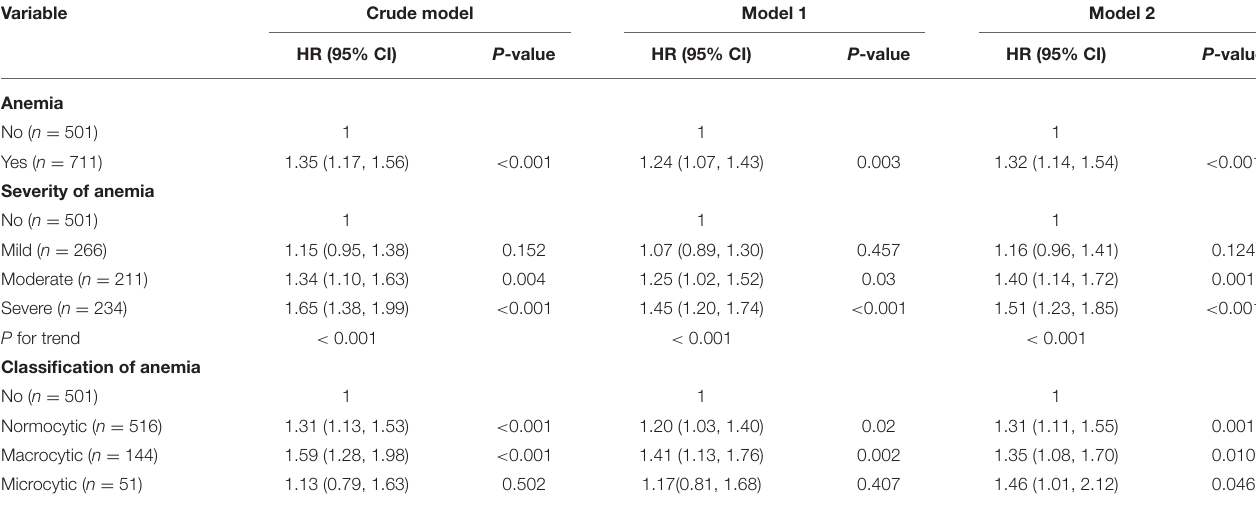
TABLE 2 | Hazard ratios for the association between anemia and all-cause mortality.